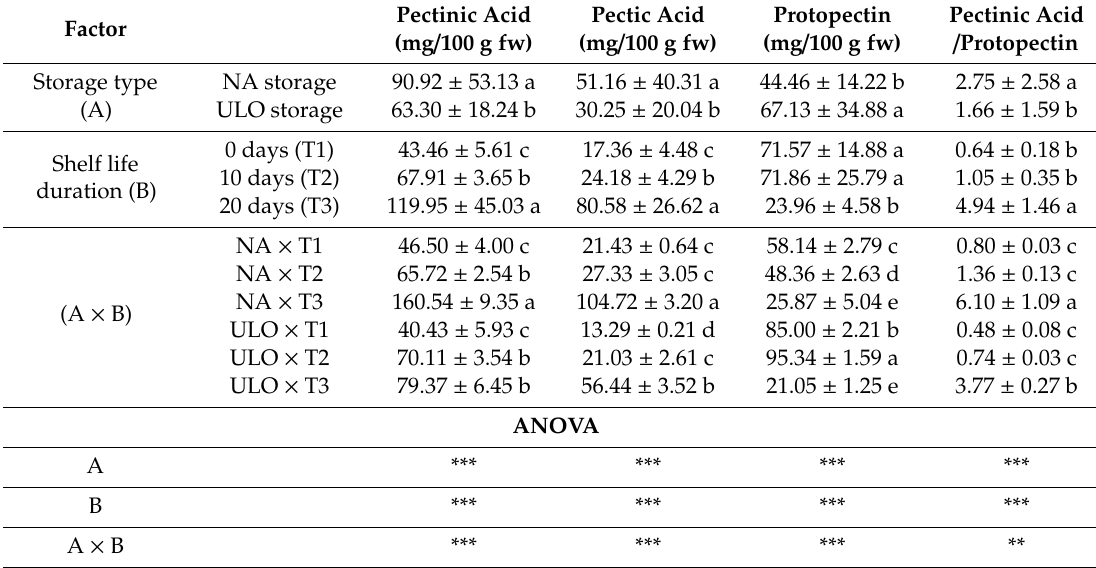
Table 3. The e ff ect of storage type and shelf life duration on the content of pectic fractions in ‘Golden Delicious’ apples.